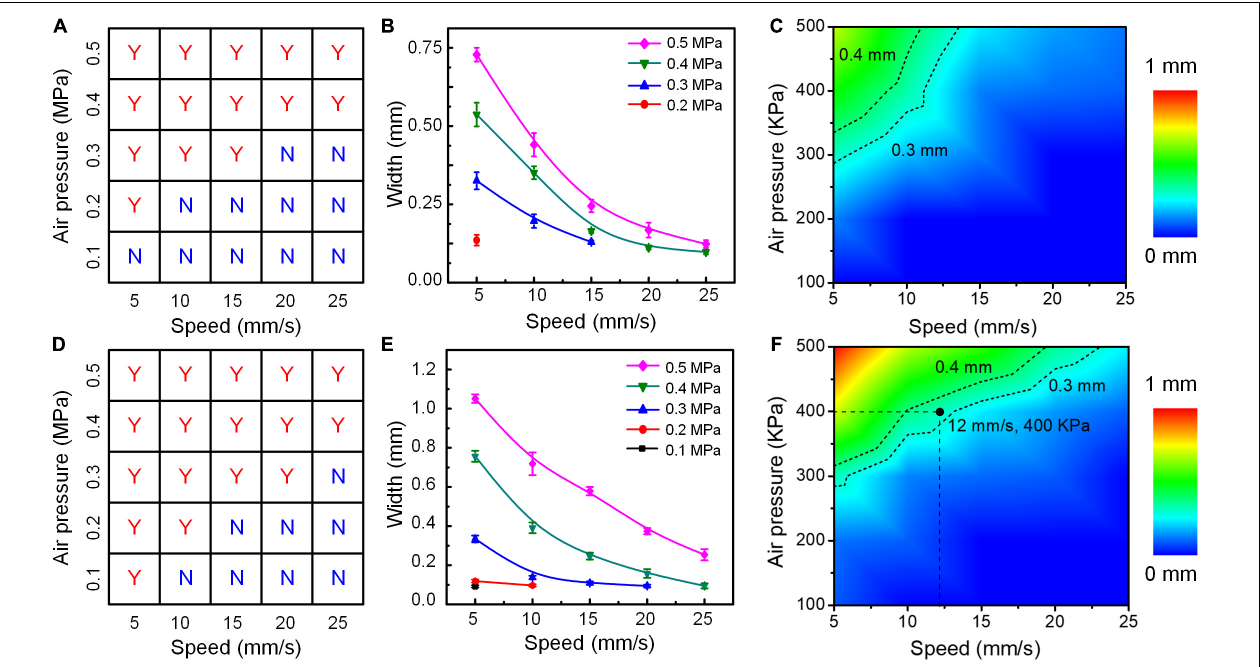
FIGURE 3 | Investigation of the effect of air pressure and moving speed on the printed filaments at 25 ◦ C (A–C) and 40 ◦ C (D–F) .